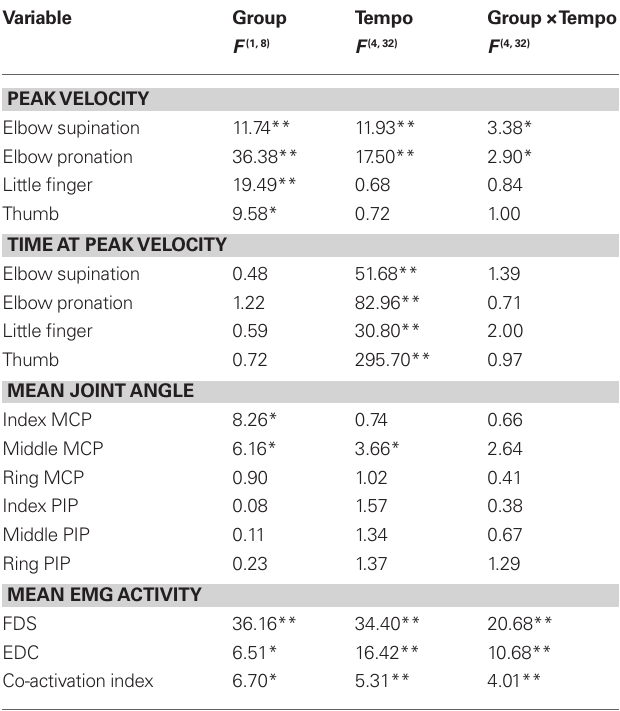
Table 2 | results of two-way ANOVA with repeated